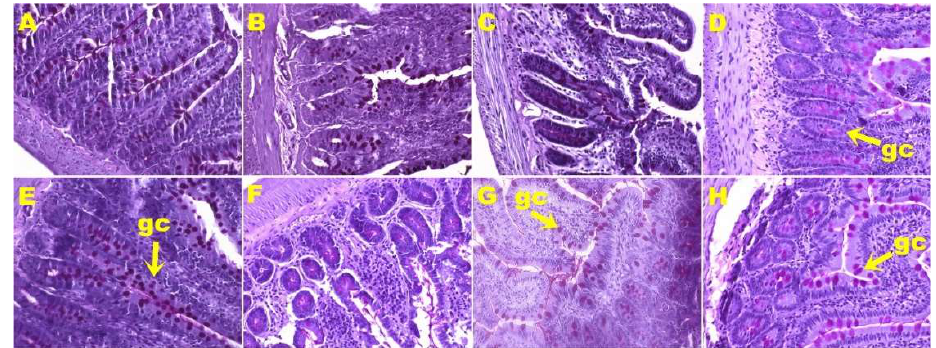
Figure 5. Periodic acid-Schiff staining of ileum showing goblet cells (magnification ×20; shown by arrows) in corn starch diet-fed rats ( A ), corn starch diet-fed rats treated with whole linseed ( B ), corn starch diet-fed rats treated with defatted linseed ( C ), corn starch diet-fed rats treated with SDG ( D ), high-carbohydrate, high-fat diet-fed rats ( E ), high-carbohydrate, high-fat diet-fed rats treated with whole linseed ( F ), high-carbohydrate, high-fat diet-fed rats treated with defatted linseed ( G ), and high-carbohydrate, high-fat diet-fed rats treated with SDG ( H ). Goblet cells are marked as “gc”.